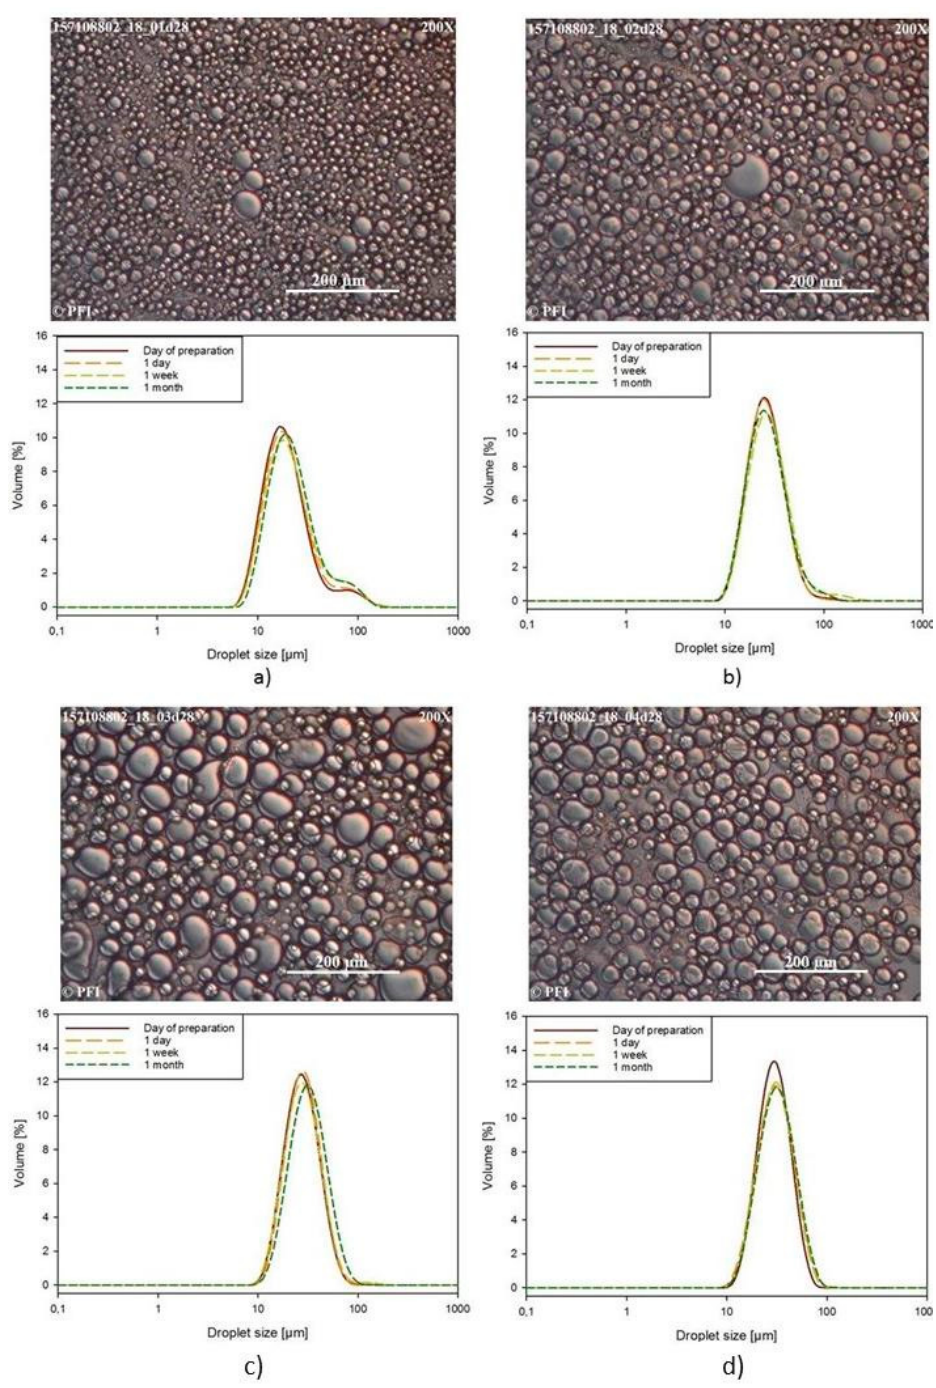
Figure 3. Light microscopy images taken after one month of storage, as well as the droplet size distributions over time for emulsions stabilized with 0.5 wt % CNF-E, for ( a ) a reference emulsion, ( b ) an emulsion with 0.2 wt % acetic acid, ( c ) an emulsion with 1.0 wt % NaCl and ( d ) an emulsion with 0.2 wt % acetic acid and 1.0 wt % NaCl.